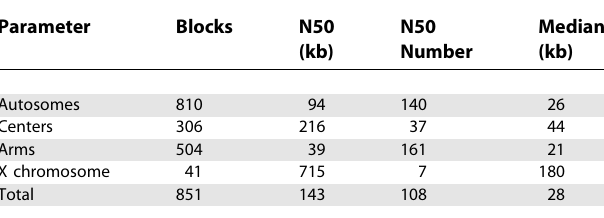
Table 5. Colinear Block Size Characteristics Parameter